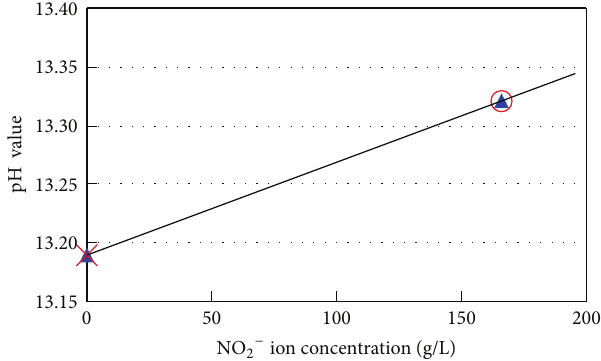
Figure 12: Relationship between NO 2− ion concentration and pH in pore solutions in